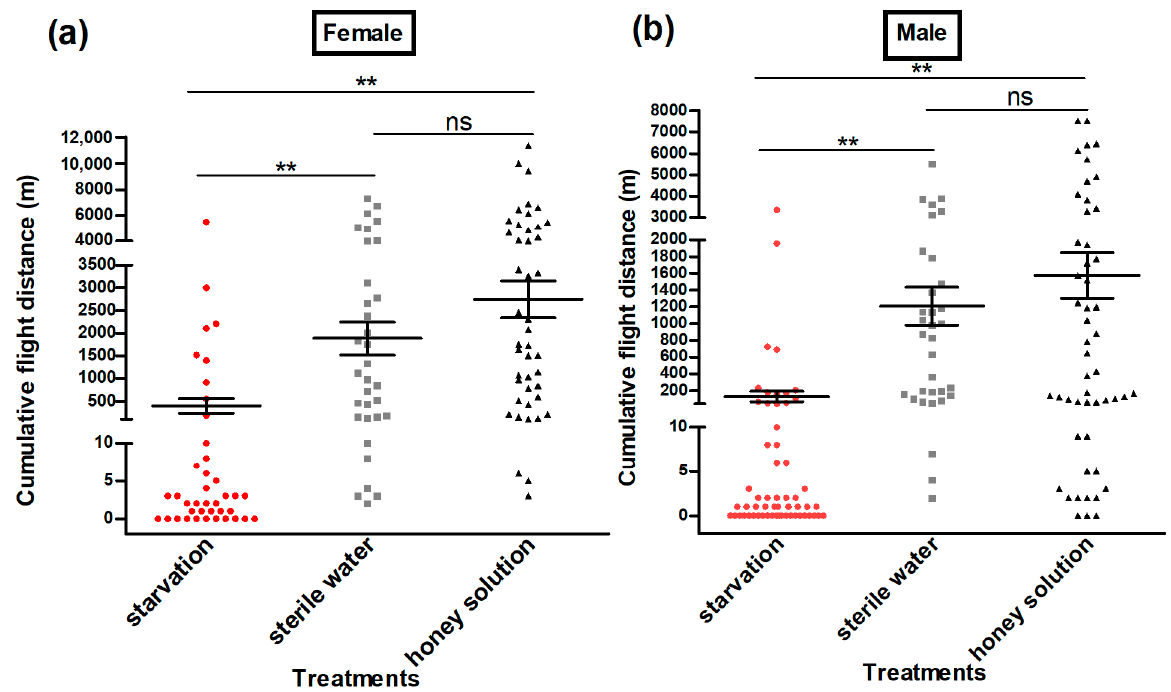
Figure 3. Cumulative flight distance (m) of female ( a ) and male ( b ) Grapholita molesta moths under different feeding treatments. The data are shown as the mean ± standard error. **, significant difference at p < 0.01; ns, means no significant difference.